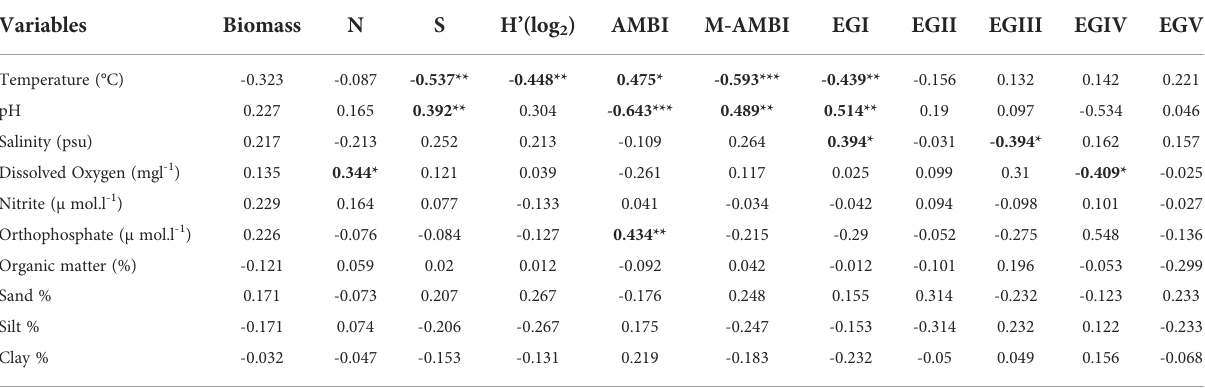
TABLE 5 Relationship between biotic indices and environmental